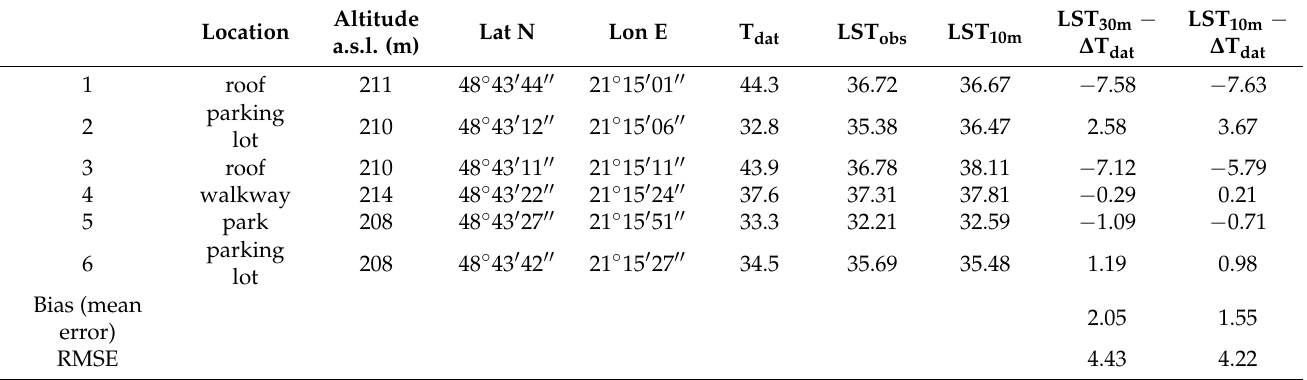
Table 2. List of the terrain stations distributed around the core of Košice city with their surface temperature measured by data logger (T dat ) compared to the corresponding LST pixel of that